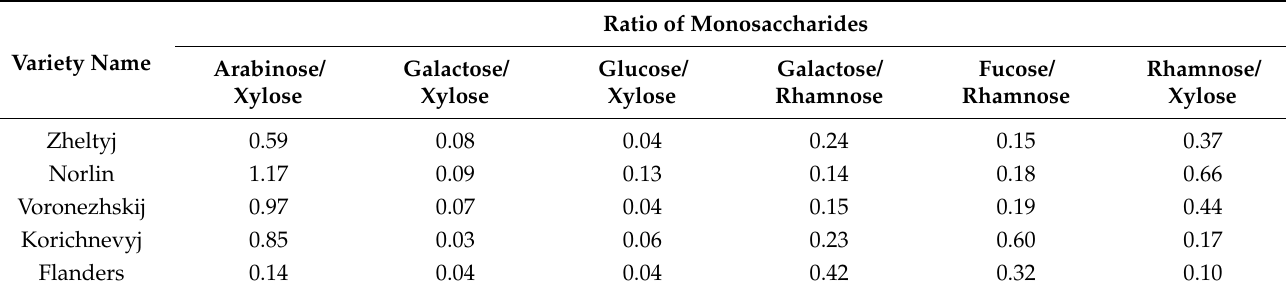
Table 7. The ratios of the contents of some monoses in mucus obtained from oil flax